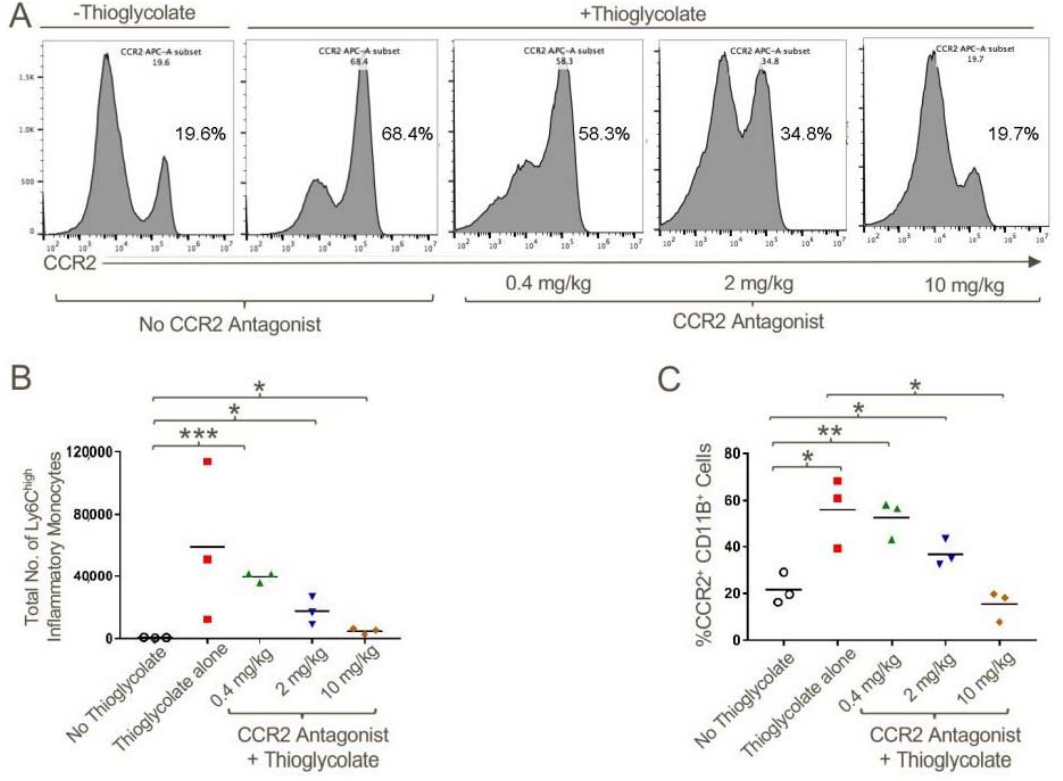
Figure 6. CCR2 antagonist inhibited the migration of CCR2 + CD11b + Ly6C high inflammatory monocytes to the site of inflammation. WT mice were injected with 4% sterile thioglycolate broth or vehicle control. Mice were treated with vehicle alone or CCR2 antagonist twice daily at a concentration of 0.4, 2 or 10 mg / kg for 48 h post-thioglycolate injections. Total number of cells in peritoneal lavage were counted. ( A ) Representative histogram plot demonstrating the increased percentage of CCR2 + cells in the peritoneal cavity in response to thioglycolate induced inflammation and abrogation of this e ff ect upon CCR2 antagonist treatment in a dose-dependent manner. ( B ) Quantification of total number of Ly6C high inflammatory monocytes and ( C ) CD11b + CCR2 + cells in the peritoneal lavage in response to the treatments noted; * p < 0.05, ** p < 0.01 and *** p < 0.001; n = 3 / group and data are representative of three independent experiments.